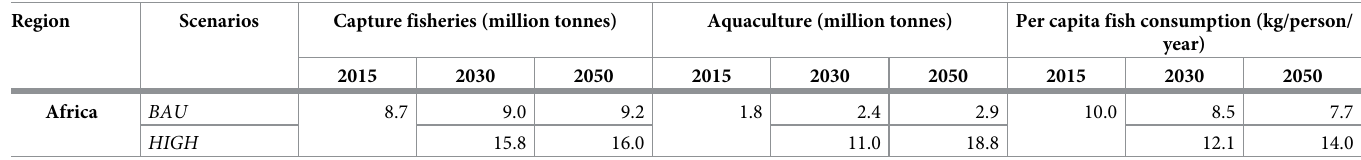
Table 3. IMPACT fish model scenario projection of fish production and per capita fish consumption for Africa in 2015, 2030, and 2050. Region